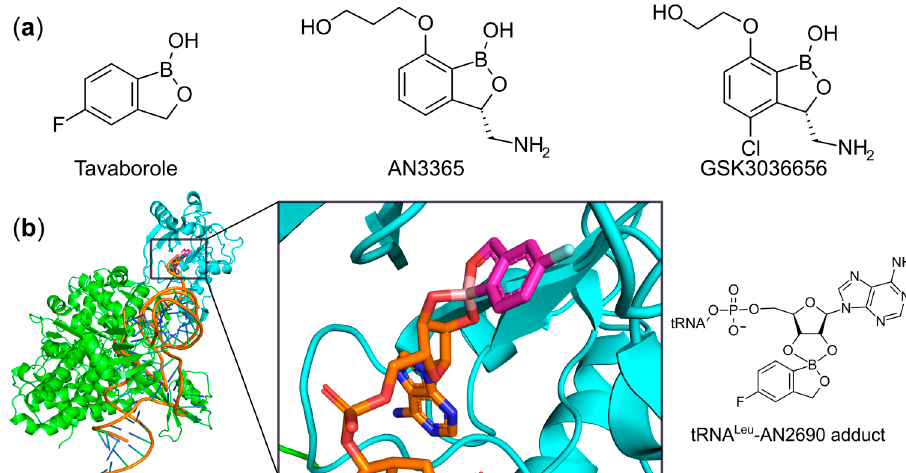
Figure 12. Structures of inhibitors targeting the editing domain of LeuRS. ( a ) Chemical structures of LeuRS inhibitors. ( b ) Ternary structure of Thermus thermophilus LeuRS in complex with tavaborole and tRNA Leu (PDB entry: 2V0G). The protein backbone and tRNA Leu are shown as cartoon representations with the editing domain of the former colored in cyan and the enzyme body in green. Inset: the terminal adenosine of tRNA Leu (orange C-atoms) and tavaborole (magenta C-atoms) form an adduct shown as sticks, the 2D-representation of the adduct is shown on the